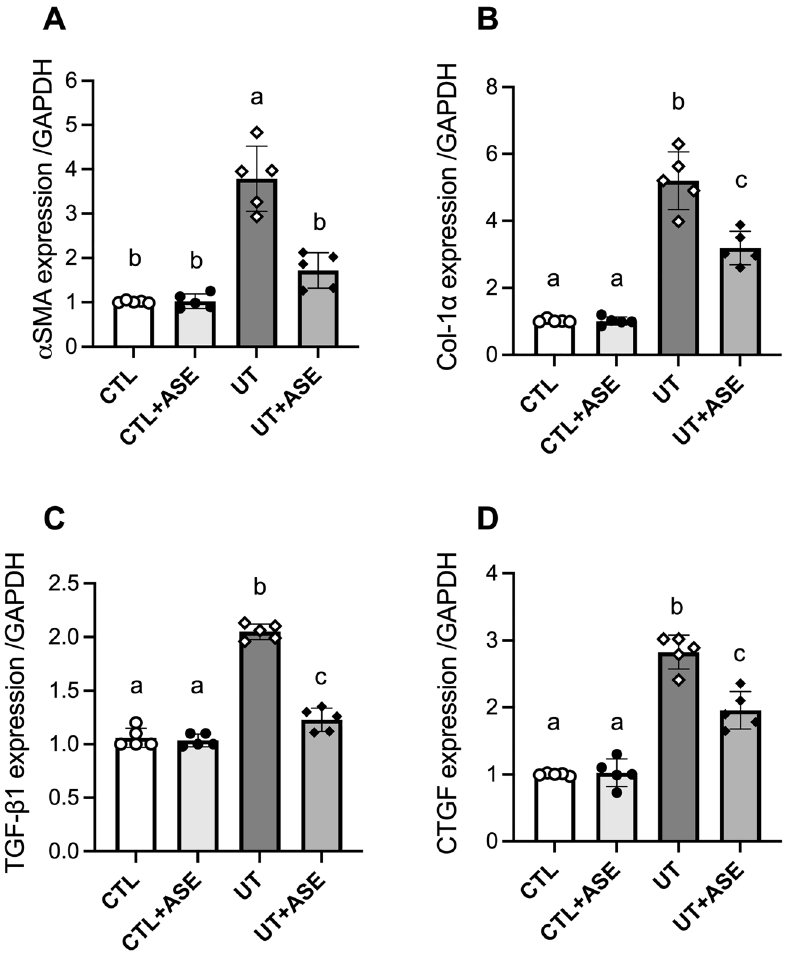
Figure 9. Treatment with ASE prevents the expression of profibrotic genes in human tubular cells exposed to uremic toxins. Human tubular cells HK2 were incubated for 16 h with two major uremic toxins, p-Cresyl sulfate (p-CS) and indoxyl-sulfate (IS) at concentrations found in patients with end-stage renal disease (200 and 212 µM for P-CS and IS, respectively) and expression of pro-fibrotic gene expression was evaluated. Gene expression of Collagen 1α (Col-1α) ( A ), transforming growth factor β1 (TGF-β1) ( B ), connective tissue growth factor (CTGF) ( C ) and α-smooth muscle actin (α-SMA) ( D ), All gene expressions were normalized to the expression of glyceraldehyde-3-Phosphate Dehydrogenase (Gapdh). Data are expressed as median for n = 5 independent experiments in each group. Significant differences were determined by Kruskall & Wallis test and posthoc Dunn’s tests. Different letters indicate a significant difference between groups at the P < 0.05